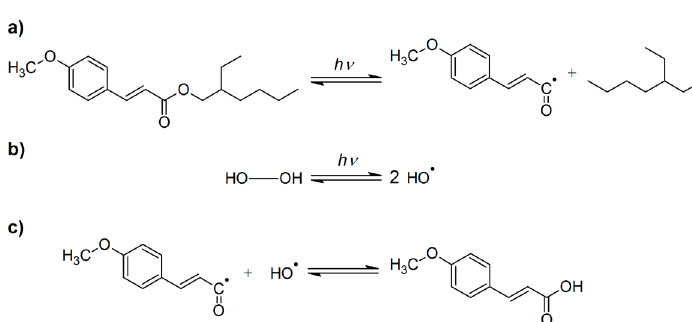
Figure 5. Radical reactions of EHMC and H